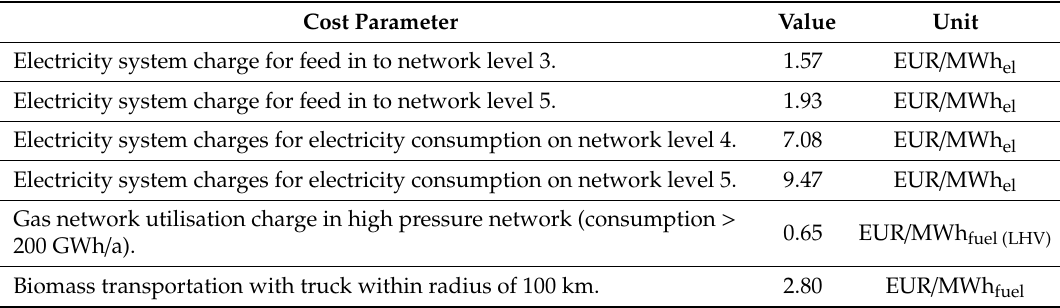
Table A3. Network and transportation cost parameter.